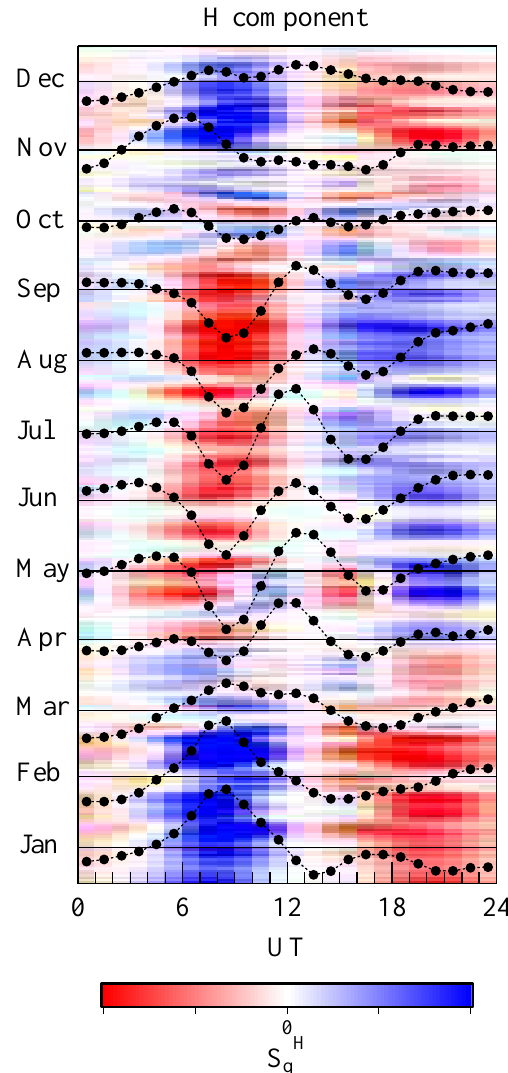
+ A 4 φ 2 φ 4 ) H H H H